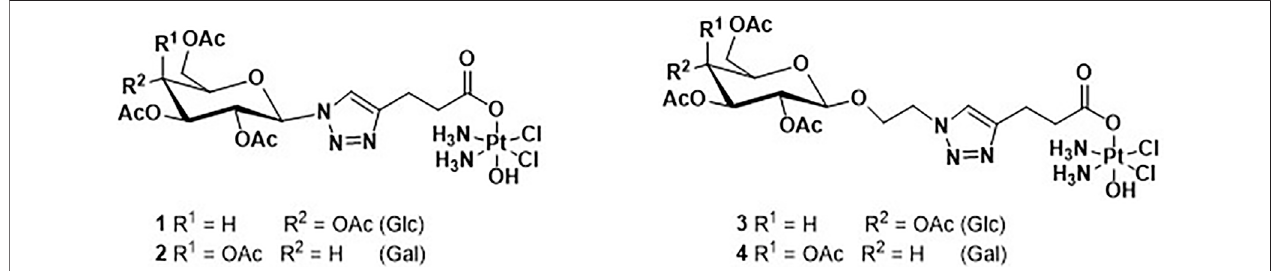
FIGURE 2 | Structure of the four novel glyco-Pt(IV) complexes (1 – 4)